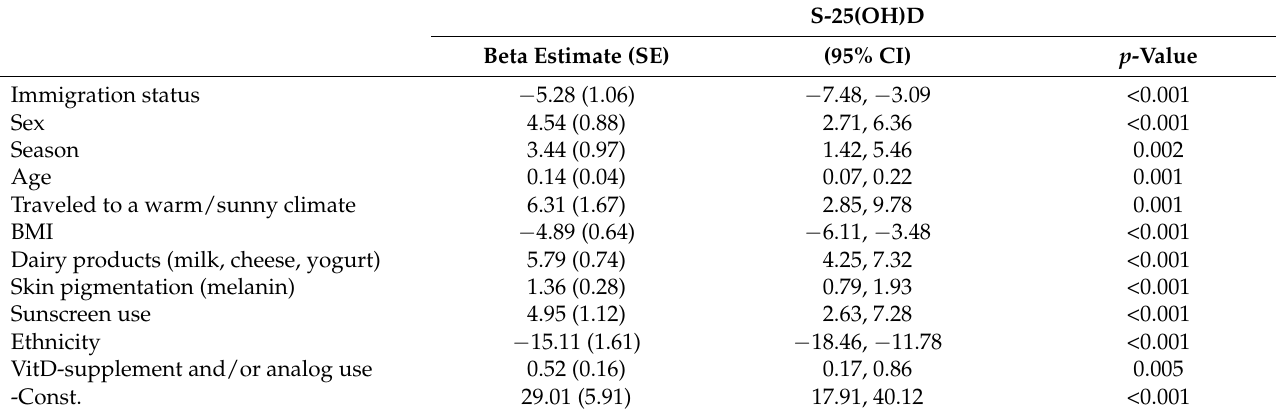
Table 5. Multivariate analysis-backward elimination method based on S-25(OH)D (nmol/L) and immigration status using Cycles 3 and 4 of Canadian Health Measures Survey